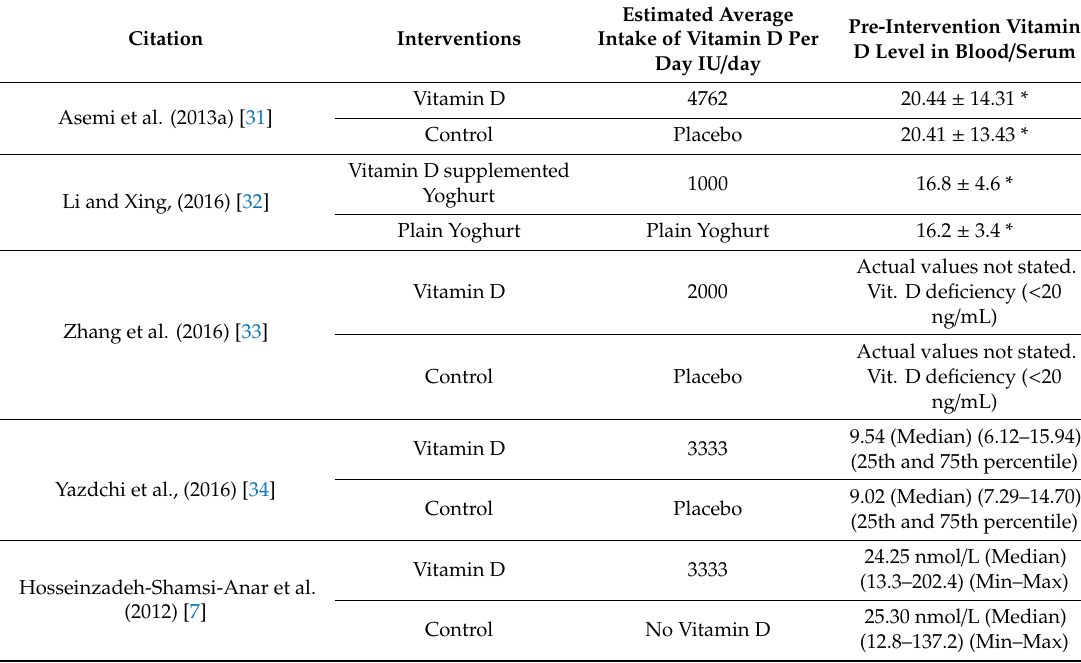
Table 2. Estimated Average Daily Intake of Vitamin D and Pre-Intervention Vitamin D Levels in Blood /